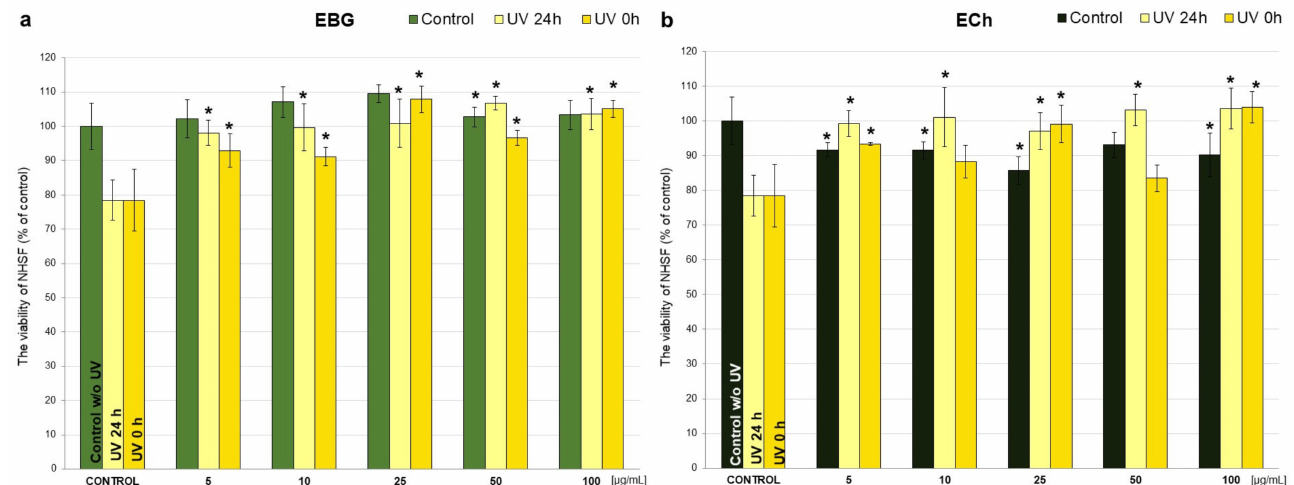
Figure 4. Effect of 70% ethanolic extract of young barley grass (EBG; ( a )) and chlorophyll (ECh; ( b )) at different concentrations (5, 10, 25, 50, 100 µ g/mL) on viability of NHSF cells without and after application of UV radiation, after 48 h incubation. Results are presented as percentage of control. * p < 0.05—statistically significant difference from corresponding control. Statistically significant difference between particular doses of the tested extracts ( p < 0.05 EBG 5 vs. ECh 5, EBG 50 vs. ECh